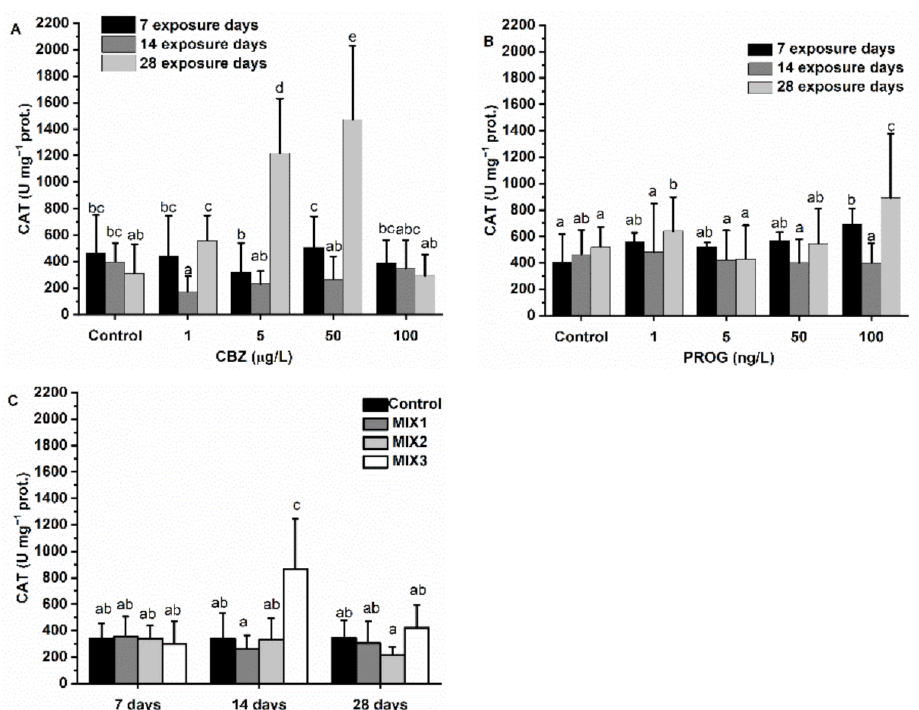
Figure 4. Changes in CAT activity in the liver of Danio rerio exposed to ( A ) CBZ, ( B ) P4, and ( C ) binary mixtures of CBZ and P4 for 7, 14, and 28 days. Data are expressed as mean ± standard deviation of fifteen replicates ( n = 15). Different letters indicate significant differences at p < 0.05 after a two-way ANOVA followed by Tukey’s post hoc